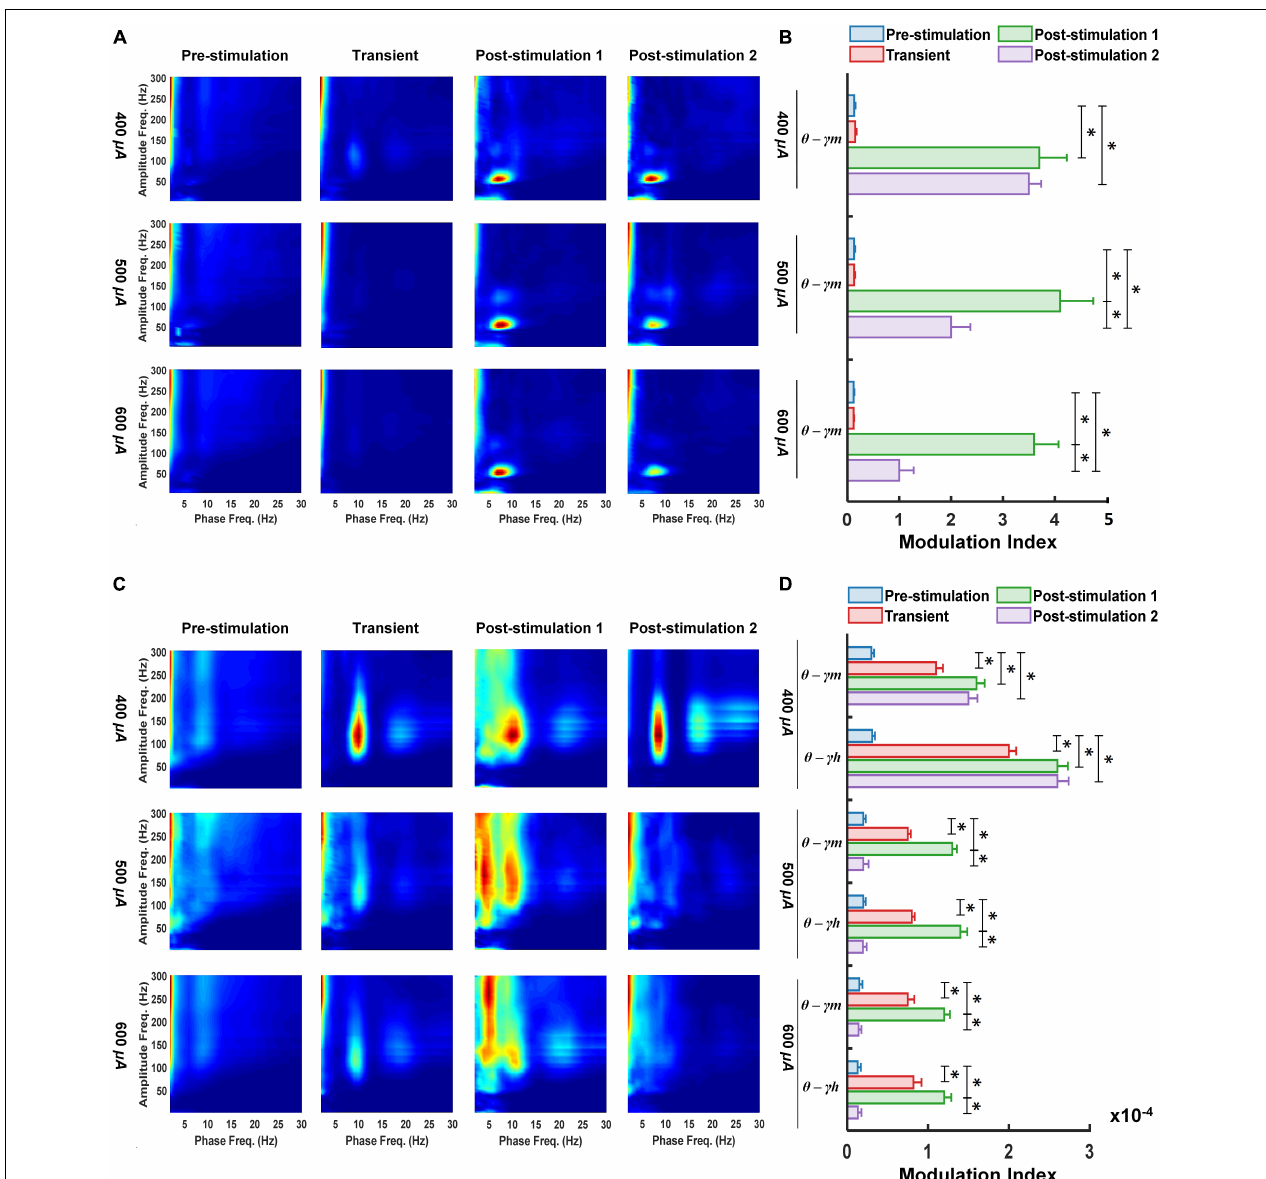
FIGURE 2 | Following retinal electrical stimulation theta waves modulates medium-gamma oscillations in the left primary visual cortex (A,B) while modulating both medium-gamma and high-gamma oscillations in the left prefrontal cortex (C,D) . (A) Phase-amplitude comodulograms was computed for ECoG signals from 400 µ A stimulation ( n = 6), 500 µ A stimulation ( n = 6), 600 µ A stimulation ( n = 6) during pre-stimulation (baseline), transient stimulation, post-stimulation stage 1 and post-stimulation stage 2. (B) Mean MI values for phases of slow theta waves (5.5–10 Hz) and amplitudes of fast medium-gamma oscillations (60–115 Hz) in the left primary visual cortex. (C) Phase-amplitude comodulograms computed for ECoG signals from 400 µ A stimulation ( n = 6), 500 µ A stimulation ( n = 6), 600 µ A stimulation ( n = 6) during pre-stimulation (baseline), transient stimulation, post-stimulation stage 1 and post-stimulation stage 2. (D) Mean MI values for phases of slow theta waves (5.5–10 Hz) and amplitudes of fast medium-gamma (60–115 Hz) and high-gamma oscillations (125–175 Hz) in the left prefrontal cortex. Twelve types of cross-frequency coupling were investigated between the three phase frequency bands [delta (0.5–5 Hz), theta (5–10 Hz) and alpha (10–15 Hz)], and four amplitude frequency bands [low gamma (30–55 Hz), medium-gamma (60–115 Hz), high-gamma (125–175 Hz), and ultra-gamma (185–300 Hz)]. θ — γ m , Theta medium-gamma coupling; θ — γ h , Theta high-gamma coupling. ∗ Significant ( P < 0.025); Error bar denotes SEM.